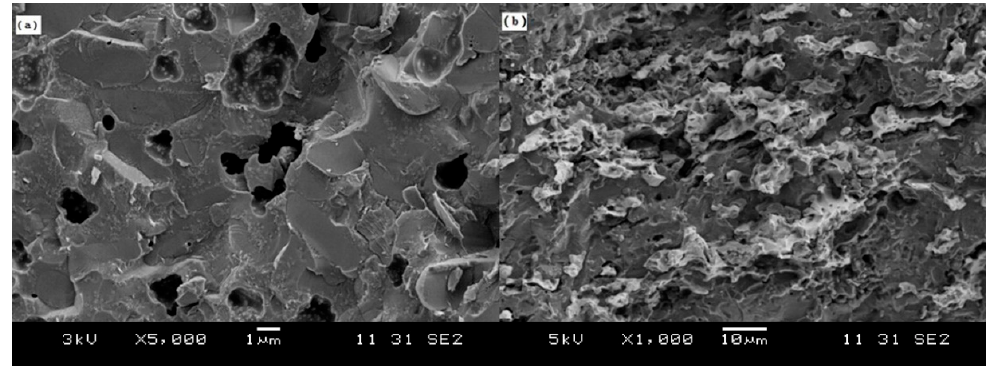
Figure 4. Microstructure of the fracture surface of the composite parallel to the pressure direction: ( a ) Al 2 O 3 /30glass; ( b ) Al 2 O 3 /30glass/30Cu f .